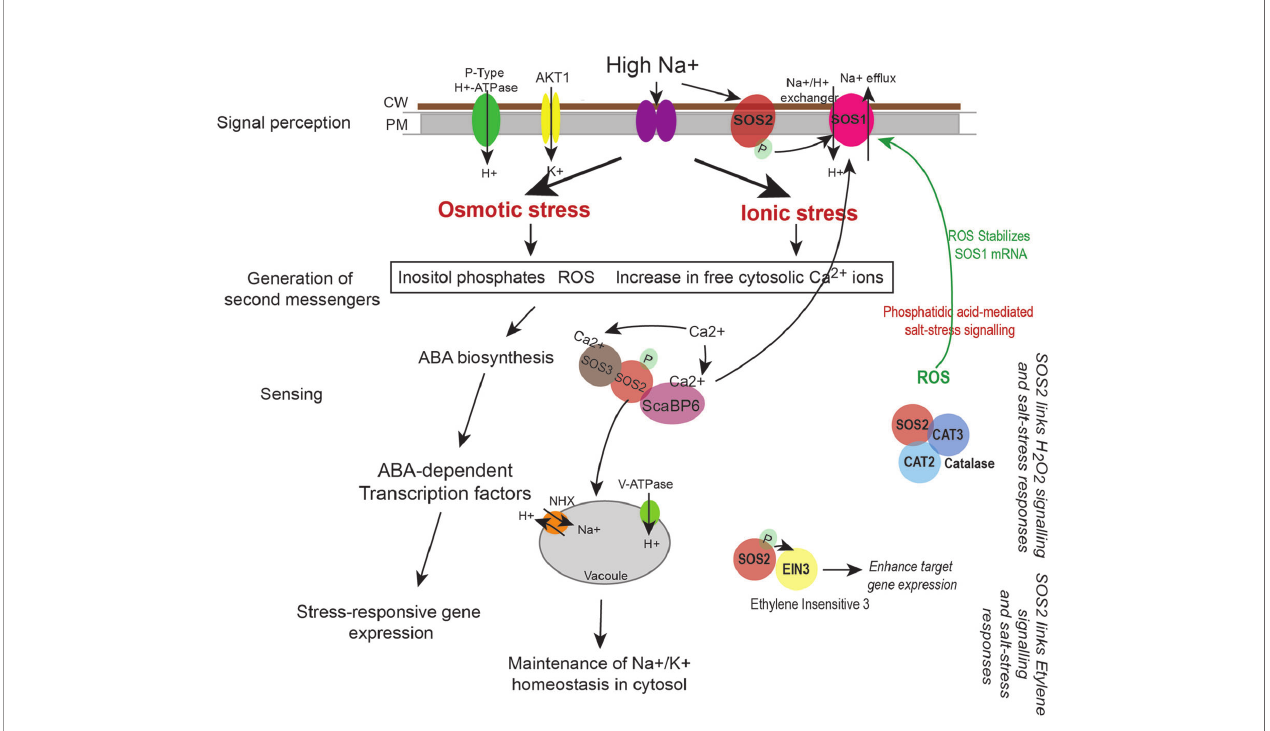
FIGURE 5 | Regulation of sodium (Na + ) and potassium (K + ) ion homeostasis by SOS pathway. High Na + ions induce osmotic and ionic stress in cells. This leads to increase in levels of cytosolic Ca 2+ , generation of reactive oxygen species (ROS), and increase in Inositol phosphates. Perturbations in Ca 2+ levels is sensed by calcium binding proteins such as SOS3 and ScaBP6 that activate the protein kinase SOS2 thus initiating a phosphorylation cascade. This leads to activation of the plasma membrane localized Na + /H + exchanger SOS1 (that ef fl uxes Na + from the cytoplasm) and the NHX exchanger on the vacuoles (that accumulate Na + in the vacuole) thus leading to maintenance of ion homeostasis in cells. Salt stress response is also linked to hydrogen peroxide (H 2 O 2 ) signaling as SOS2 directly interacts with CATALASE (CAT2 and CAT3), while its interaction with Ethylene Insensitive 3 (EIN3) links SOS pathway to ethylene signaling processes (Verslues et al., 2007; Quan et al., 2017). ROS and stress responsive changes in gene expression may also lead to biosynthesis of phytohormones such as ABA that can amplify the stress signal by activating ABA-dependent transcription factors that lead to expression of stress-responsive